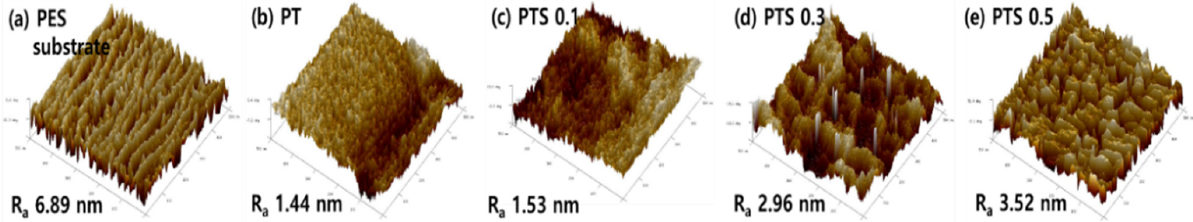
Figure 7. Three-dimensional AFM images of the thin-film composite membranes: ( a ) PES hollow fiber substrate, ( b ) PT, ( c ) PTS 0.1, ( d ) PTS 0.3, and ( e ) PTS 0.5.